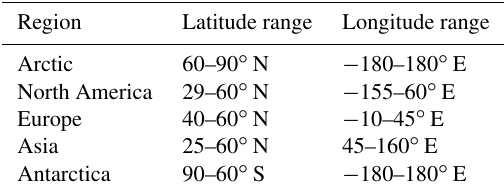
Table 4. Domain of the regions used in this study.